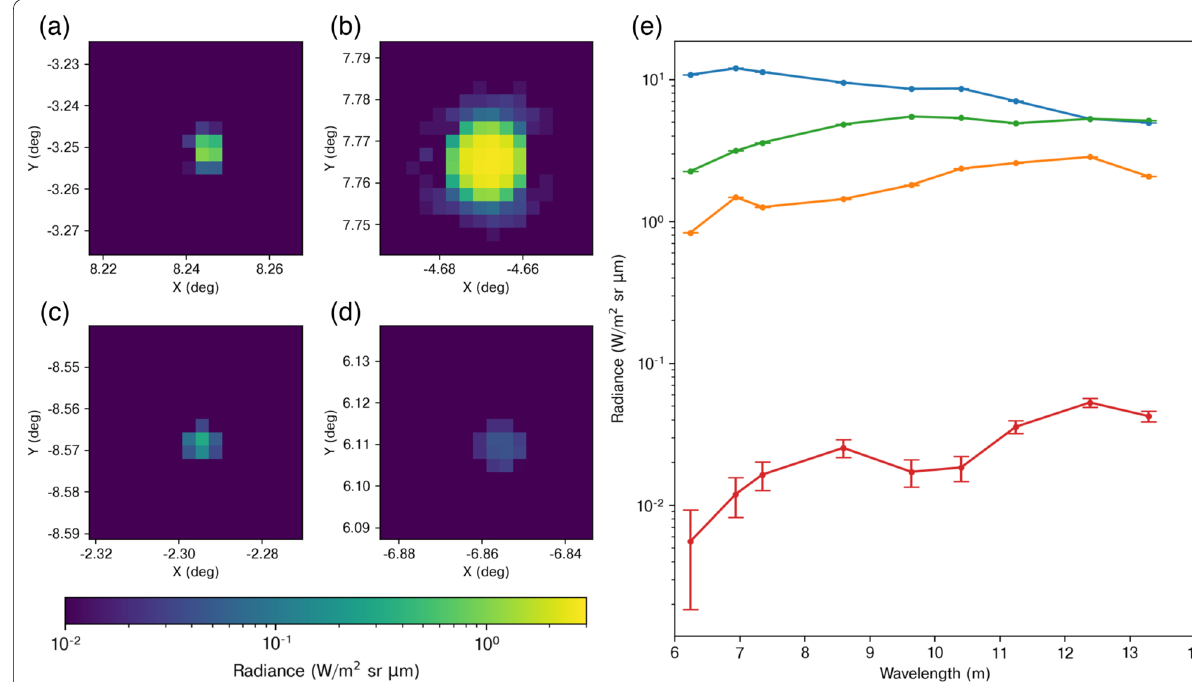
Fig. 12 Examples of planetary images at band 14 of AHI: a Mercury, b Venus, c Mars, and d Jupiter. The images were taken from data at 2016/08/29 16:20, 2017/03/30 13:40, 2017/01/01 18:20, and 2016/03/11 02:10, respectively. e The disk-normalized infrared spectrum of planets. The blue, orange, green, and red lines correspond to a , b , c , d , respectively. The error bars show the background noise level in the